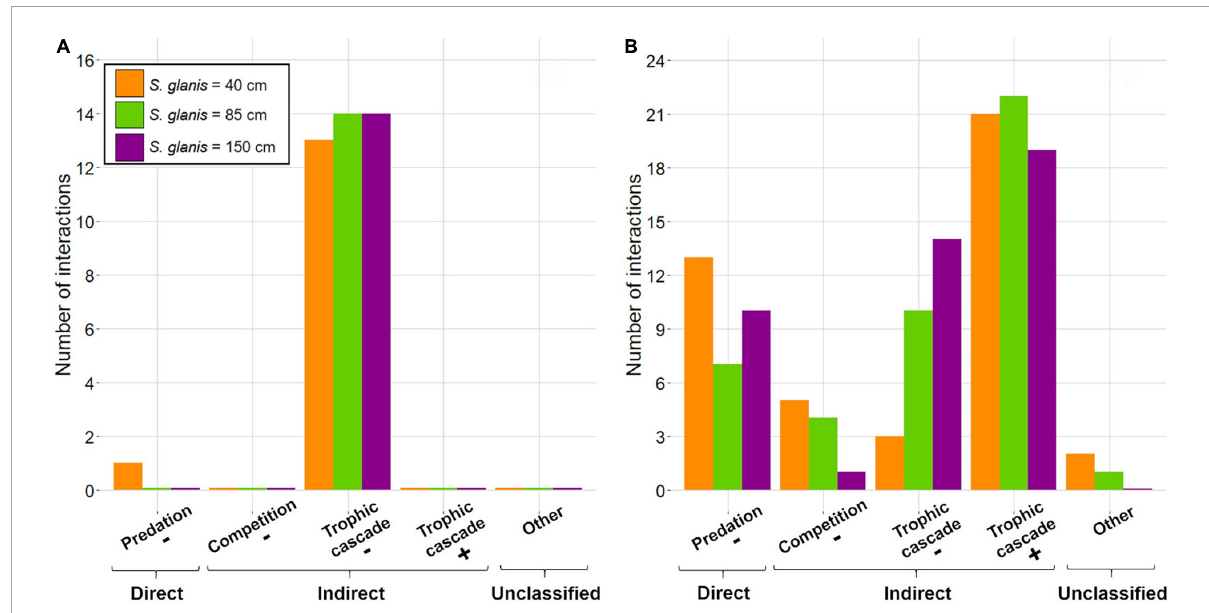
FIGURE4 Ecological interactions involved in time lags for extinct species clusters (A) and for species clusters submitted to abundances changes (B) in the whole invaded food-web typical of large French peri-Alpine lakes. The “–” corresponds to interactions with negative impacts on species cluster abundances (i.e., MRAD < 0). Contrary, “+” is used for interactions with positive impacts on species clusters abundances (i.e., MRAD >